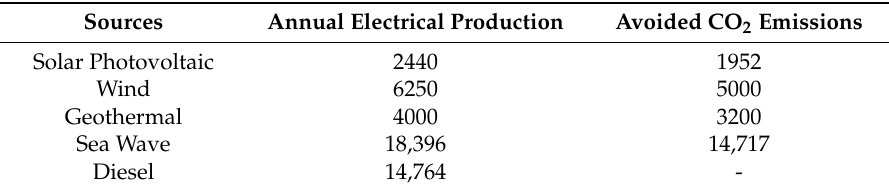
Table 5. Electrical production and avoided CO 2 emissions by sources.